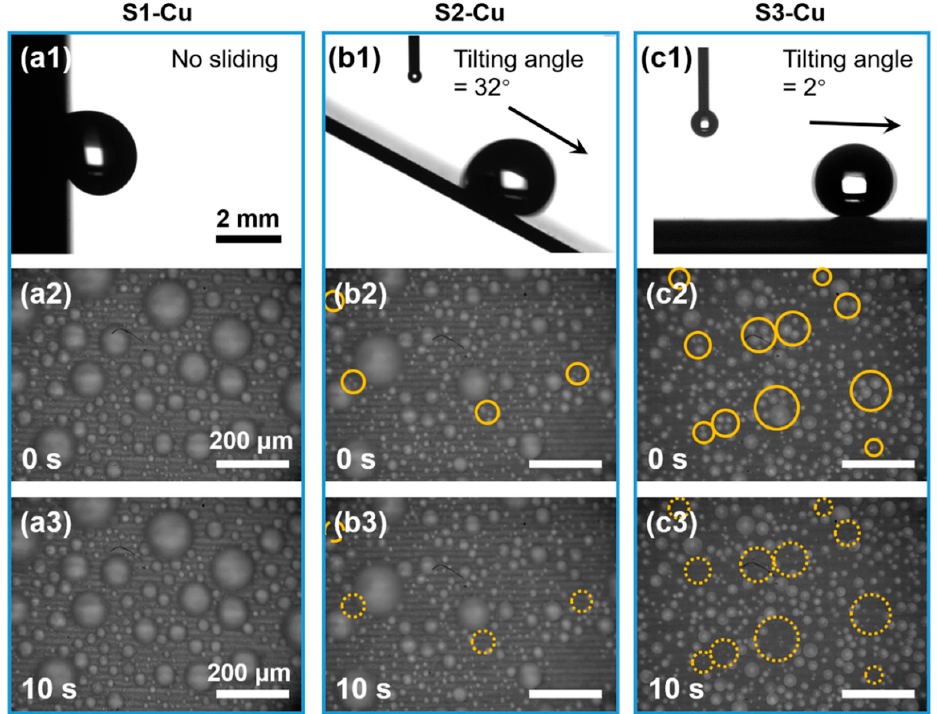
Figure 2. Wetting properties of sessile macroscale and condensed microscale droplets on the Cu samples. ( a1 – c1 ) Sliding behavior of deposited macroscopic droplets on S1-Cu, S2-Cu, and S3-Cu, respectively. ( a2 , a3 ) S1-Cu, condensed microdroplets fail to jump through coalescence, which leads to a high amount of accumulated water. ( b2 , b3 ) S2-Cu, condensed microdroplets jump with low efficiency. ( c2 , c3 ) S3-Cu, condensed microdroplets jump efficiently through coalescence, where they can be promptly removed from the surface before growing large. The images are taken 30 min after the onset of condensing, and the droplet jumping frequency on the surfaces is illustrated over a 10-s interval. The droplet jumping frequency may be determined by the surface morphology.